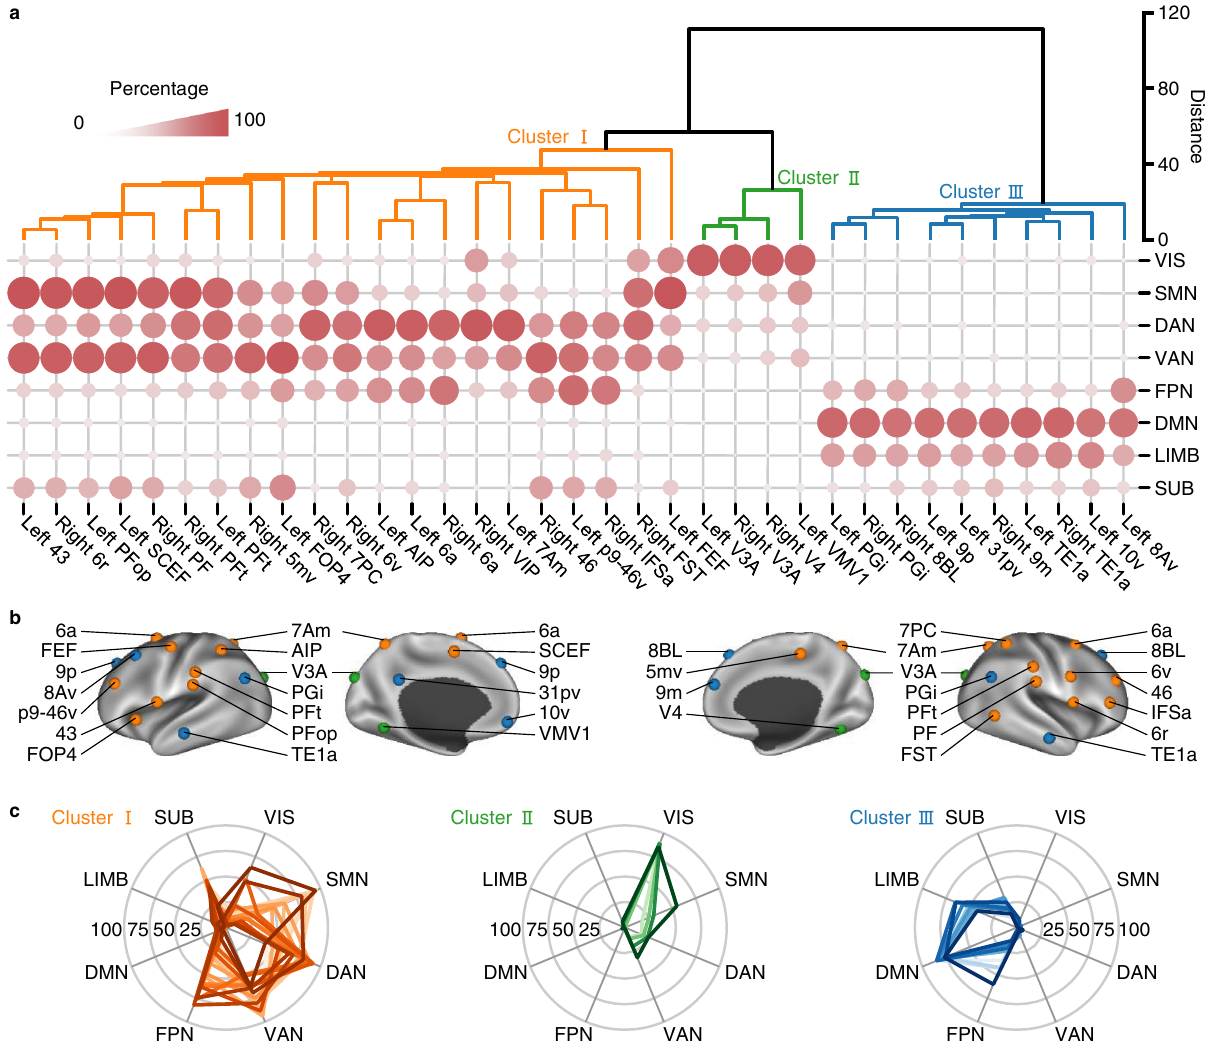
Fig. 4 Hierarchical clustering analysis on connectome hubs ’ functional connectivity maps. a Dendrogram derived by hierarchical clustering on the connectivity percentage matrix. b The 35 hubs were rendered using three different colors according to the hierarchical clustering solution. c Radar charts showing heterogeneous connectivity pro fi les of the three hub